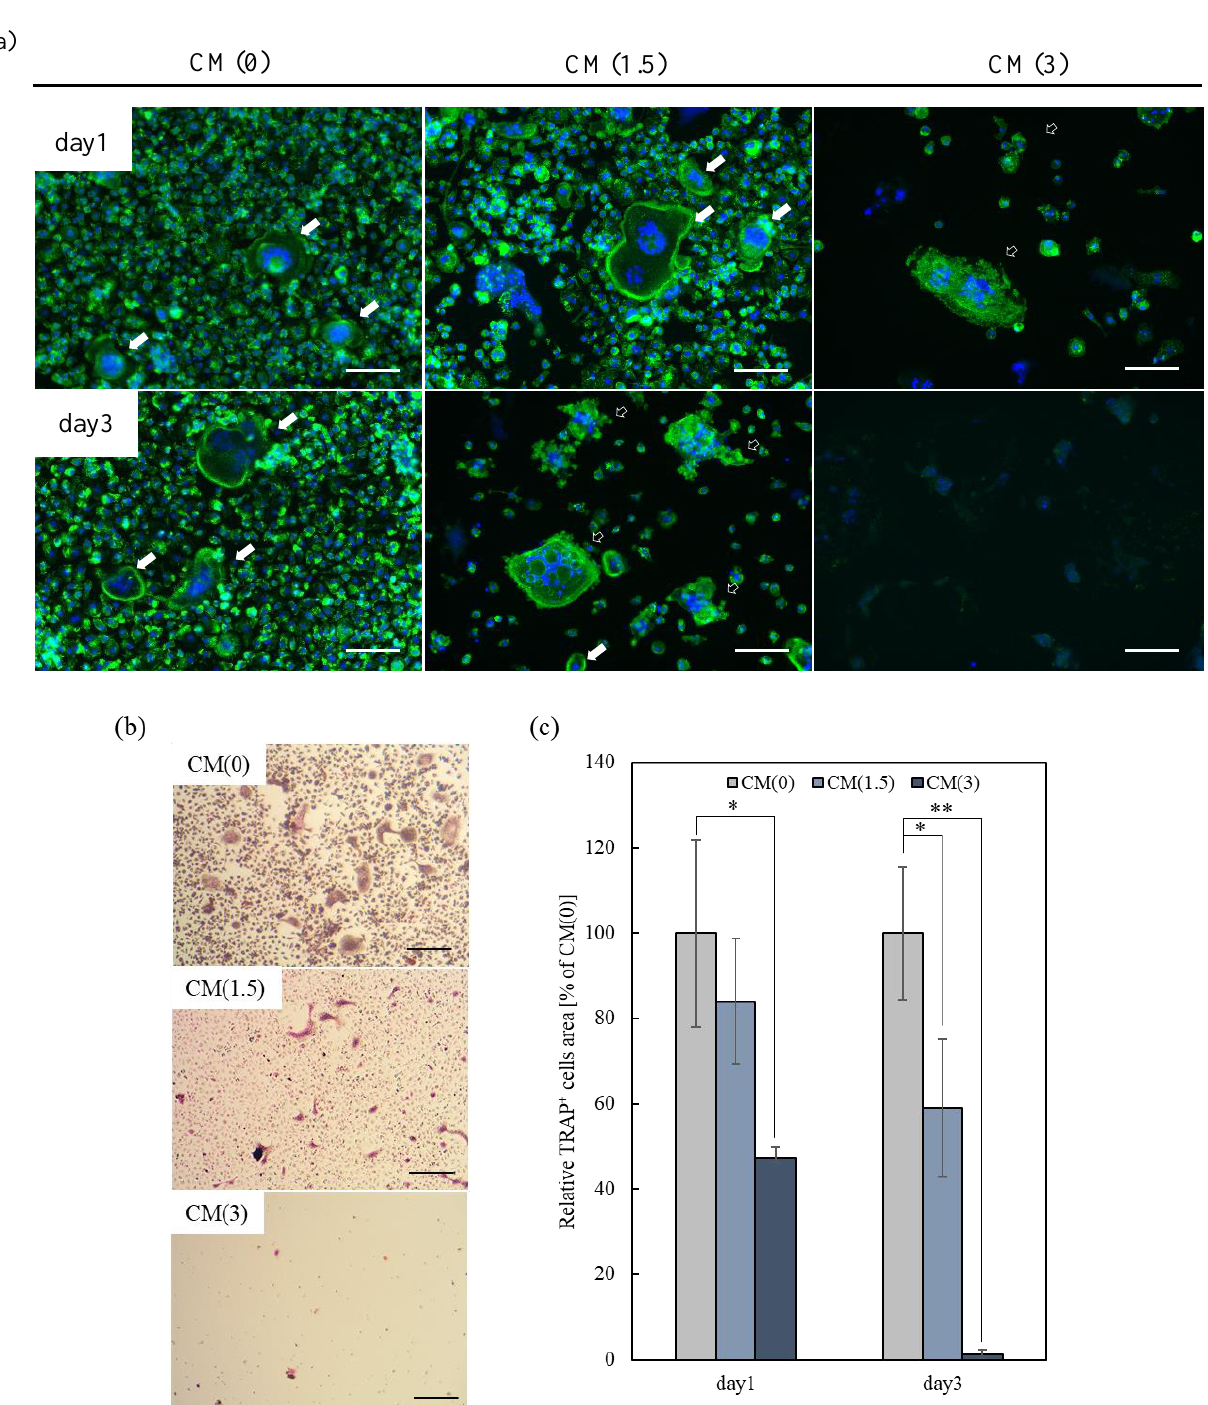
Figure 9. Effect of free-ZOL for mBMSCs activation. mBMSCs were treated with osteoclastic (on the ZOL/β-TCP disc) conditioned medium for 1, 3 days (day 1, 3). ( a ) Morphological observation of mBMSCs. mBMSCs were stained with Alexa Flour ® 488-labeled phalloidin for F-actin (green) and DAPI for nuclei (blue) and observed by fluorescence microscopy. Scale bars; 100 µ m, filled white arrows; osteoclasts (cell with more than 2 nuclei), open white arrows; abnormal shape of osteoclasts. ( b ) Observation images of TRAP activity staining at day 3. Red; TRAP + cells, scale bars; 200 µ m. ( c ) Relative TRAP + cells area was analyzed by image analyzer. Error bars indicate standard deviation of the mean. The asterisks show * p < 0.05, ** p < 0.01 as compared with conditioned medium 0 (CM(0)) by Student’s t -test.